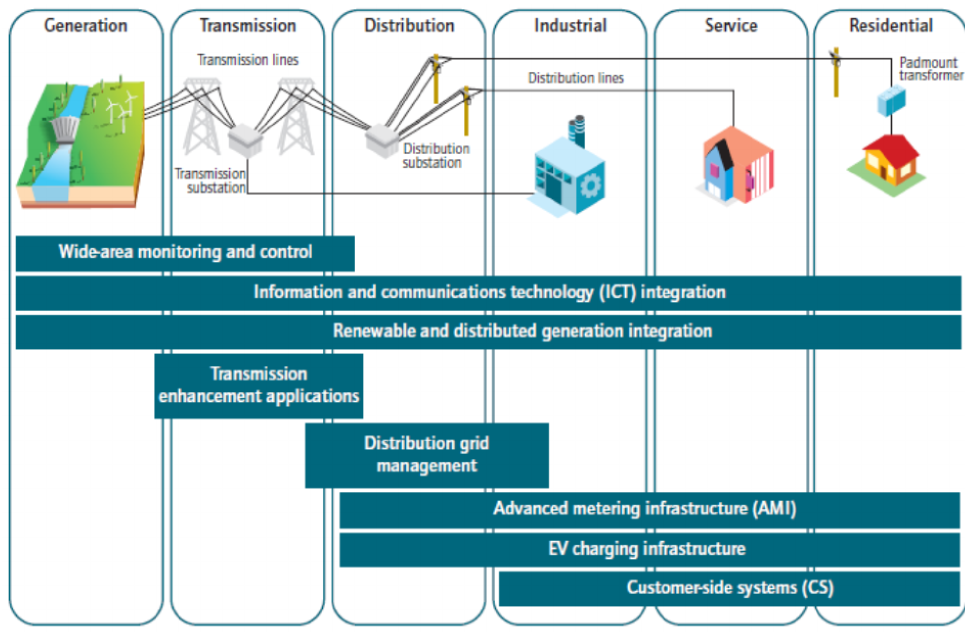
Figure 3. Smart Grids Technologies by